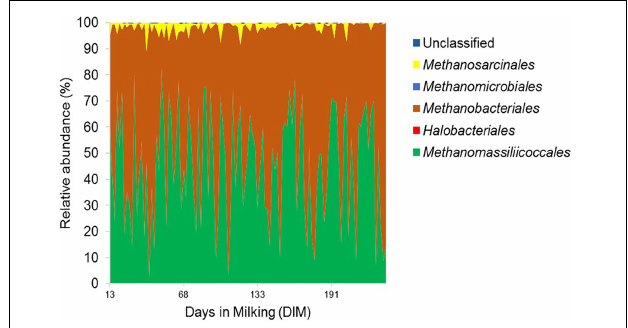
FIGURE 2 | Order level composition of the rumen archaeal community. Archaeal 16S rRNA gene profile is shown in area graph and distinct orders are indicated by different colors. The x -axis represents days in milking (DIM) of cows ranging from day 13 to day 320 and the y -axis represents the relative abundance of bacterial